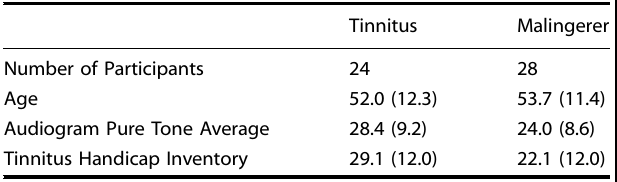
Table 1. Mean demographic for the tinnitus patient and malingerer